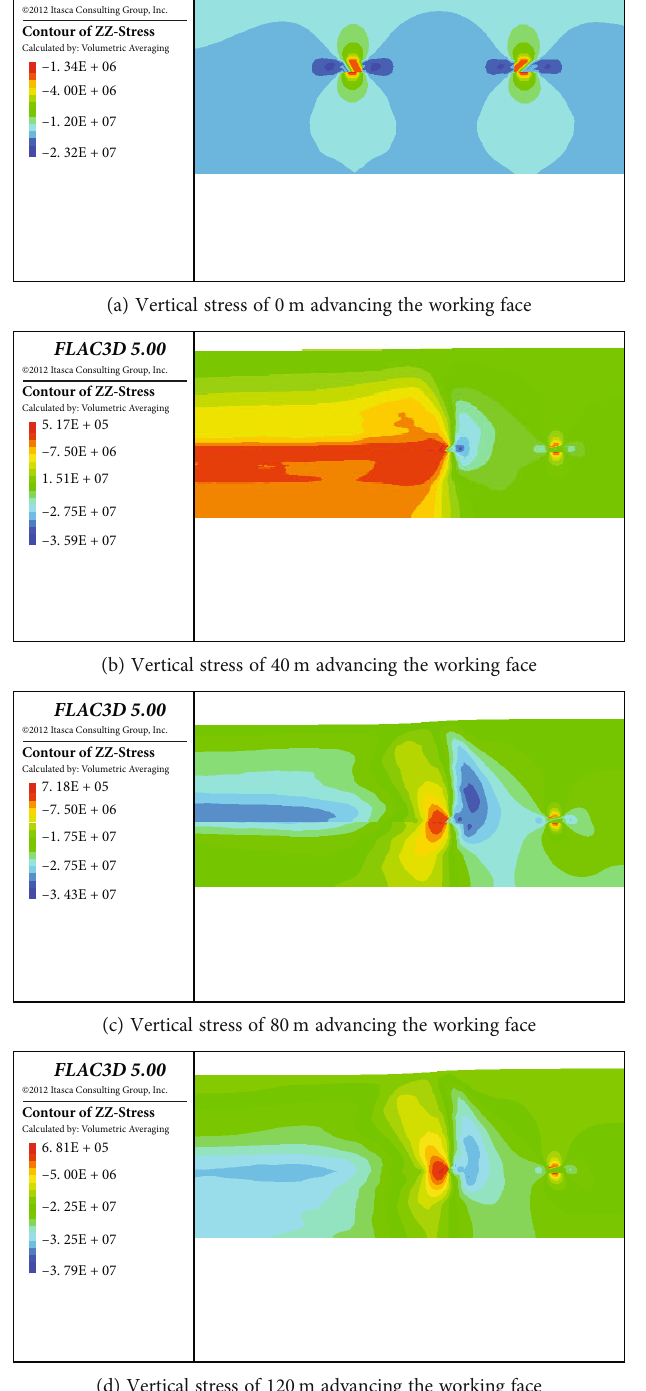
Figure 9: Vertical stress diagram of coal pillar during No. 4102 working face